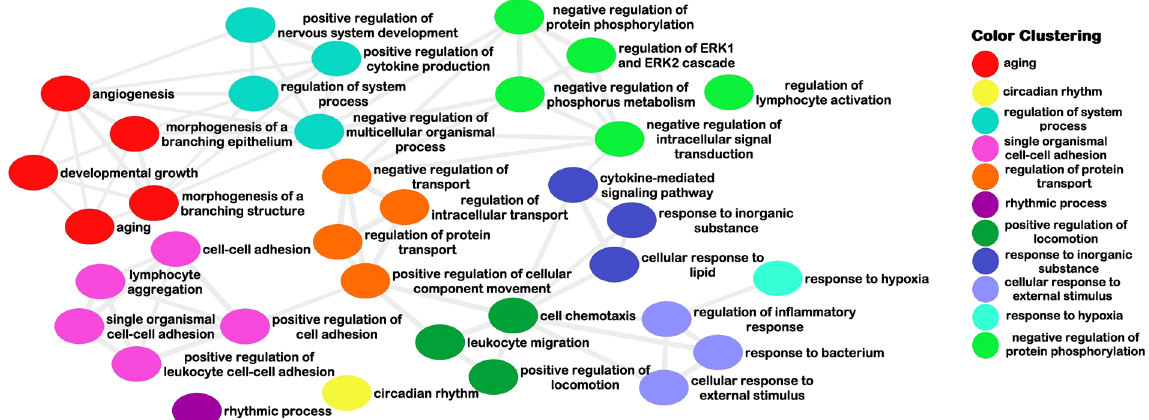
Figure 3. Graph for the results of enrichment analysis for five gene sets up-regulated in POP. More similar nodes are placed closer together. The line width indicates the degree of similarity between GO terms cluster representatives. Clustering by color into super clusters was obtained by using REVIGO TreeMap